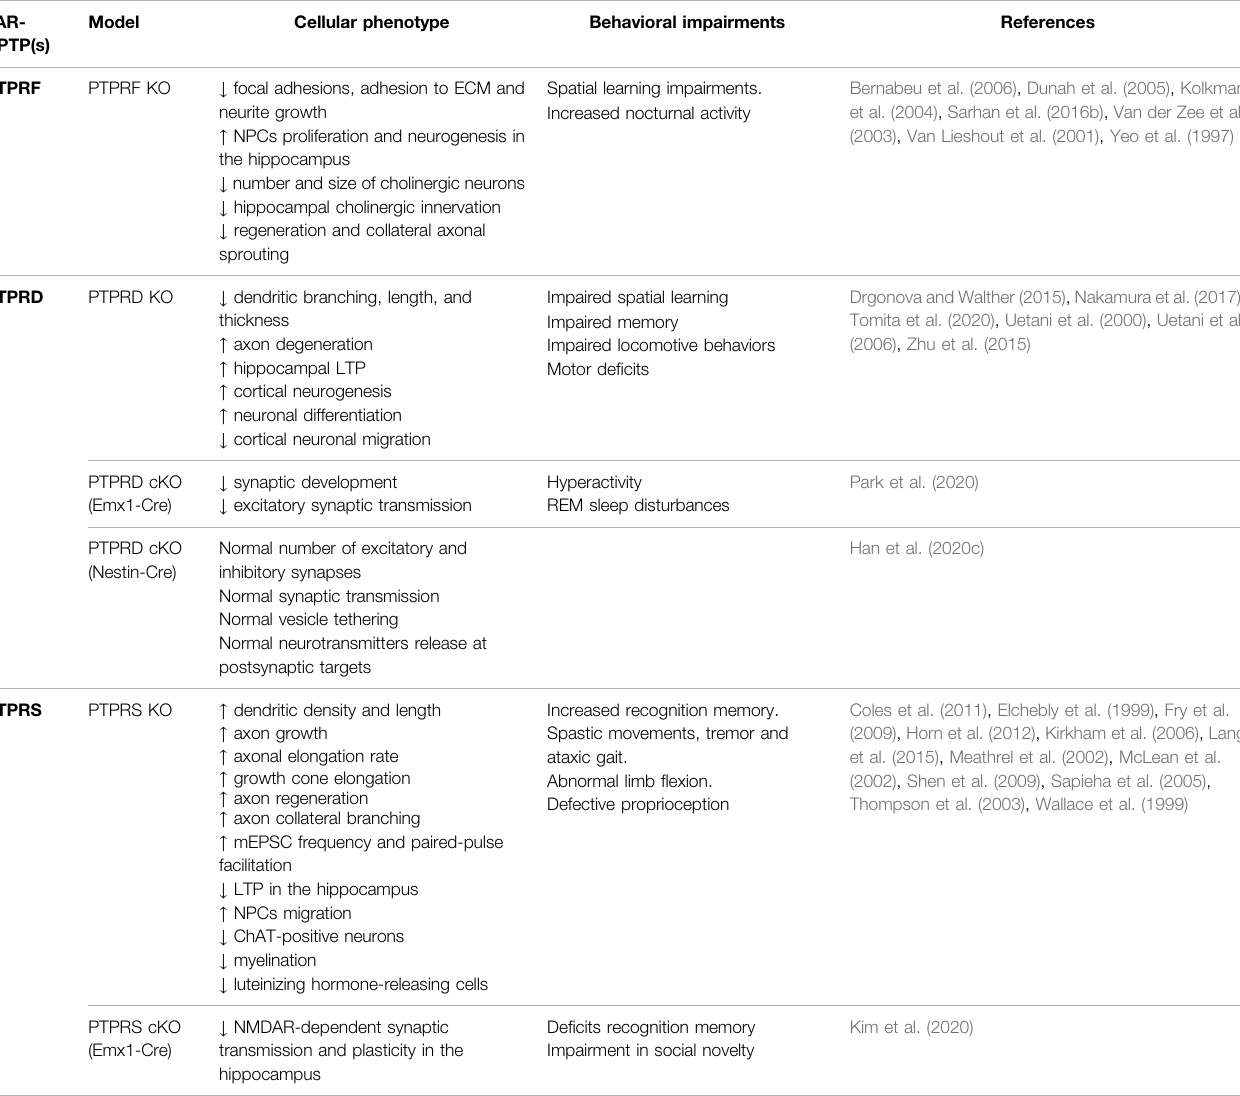
TABLE1| LAR-RPTPsknockoutmodelsandtheirphenotypes.DifferentanimalmodelslackingLAR-RPTPsexpressionanditsinducedphenotypehavebeensummarized. LAR- RPTP(s)